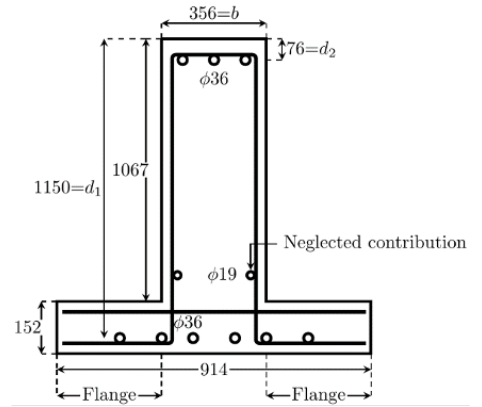
Figure 6. Cross-sectional details of inverted-T beams (unit: mm).